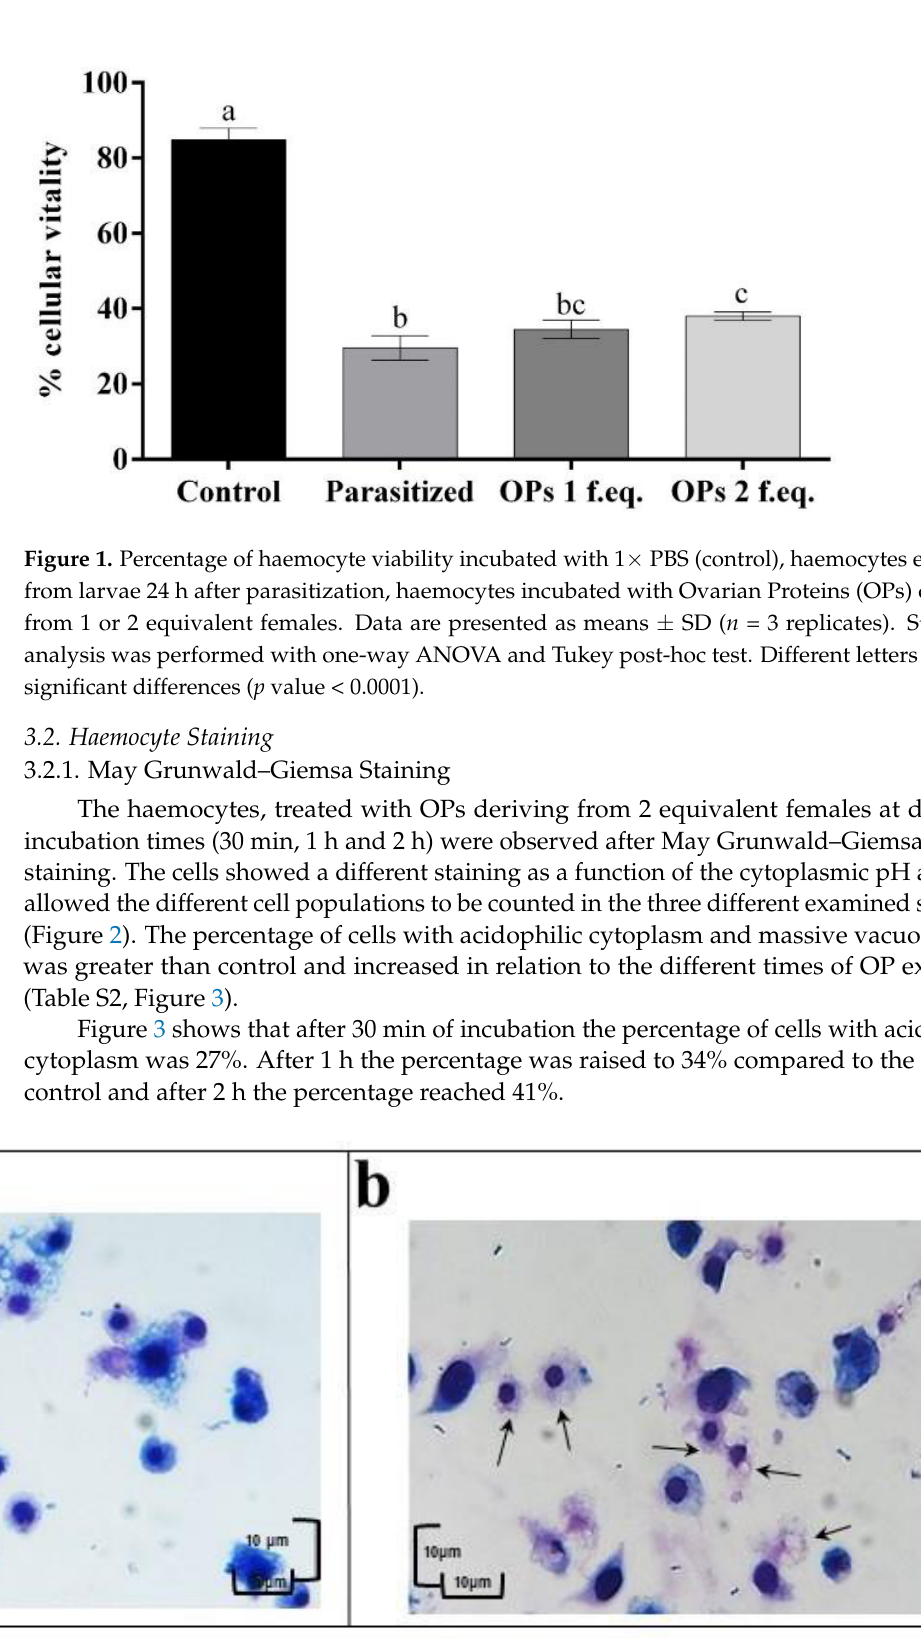
Figure 3. Percentage of haemocytes showing vacuolization, after treatment with OPs deriving from 2 equivalent females at different incubation times (30 min, 1 h and 2 h) and observed after May Grunwald – Giemsa (MGG) staining. Data are presented as means ± SD ( n = 3 replicates). Statistical analysis was performed with one-way ANOVA and Bonferroni (for control vs treatment analysis) and Tukey post-hoc test (for all sample analysis). Different letters indicate significant differ- ences among all treatments ( p value < 0.0001), asterisks indicate significant differences between control and treated sam- ples at the same experimental time (** p value < 0.01; **** p value < 0.0001). 3.2.2. H 2 DCFDA Staining Haemocytes treated with OPs (2 equivalent females) at different times (30 min, 1 h and 2 h) were stained with 2,7 dichlorodihydrofluorescein acetate (H 2 DCFDA). H 2 DCFDA after entering into the cells, were converted into dichlorodihydrofluorescein (H 2 DCF) by intracellular esterases, H 2 DCF is rapidly oxidized to a highly fluorescent compound, 2,7- dichlorofluorescein (DCF), only in the presence of reactive oxygen species (ROS). Figure 4 and Figure S2 show a strong fluorescent signal indicative of high oxidative stress in cells incubated for 2 h with OPs and a very weak fluorescent signal that could constitute the background experiment and/or could be indicative of cell physiological presence of ROS at low concentrations in control cells.